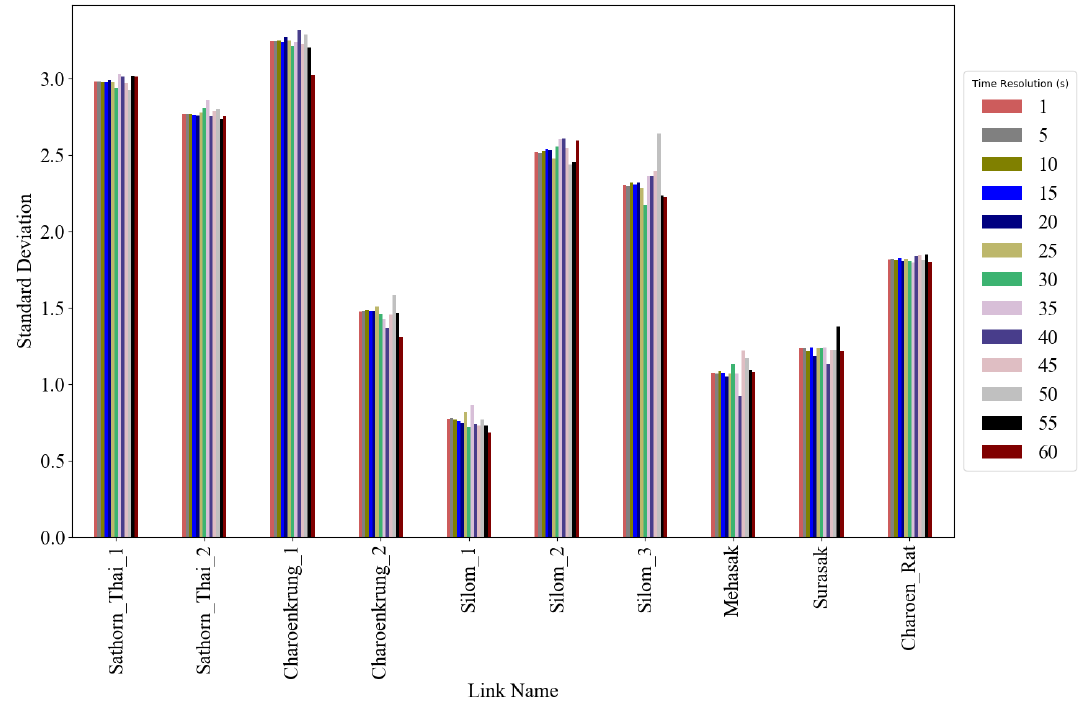
Figure 7. Standard deviation of the mean speed of GPS vehicles on each upstream/downstream link for a sample size of 30% for each time